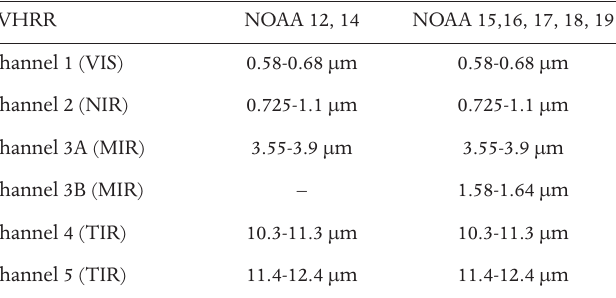
Table 1. AVHRR spectral sensor